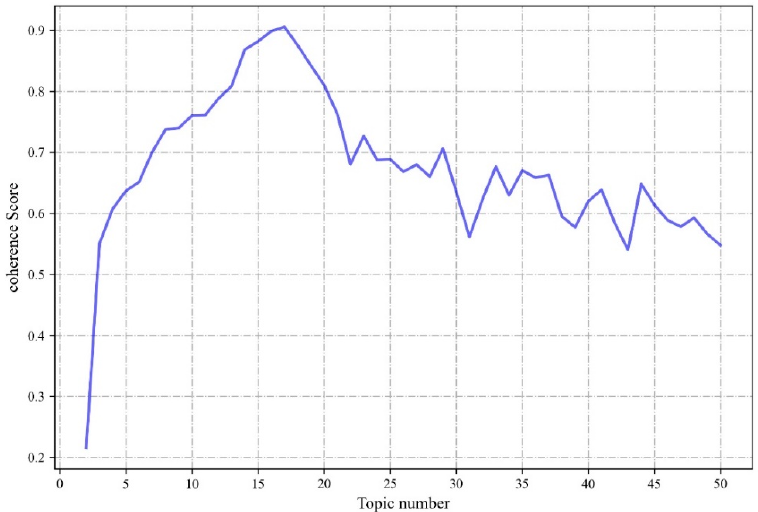
Figure 8. The change of topic coherence with topic number.